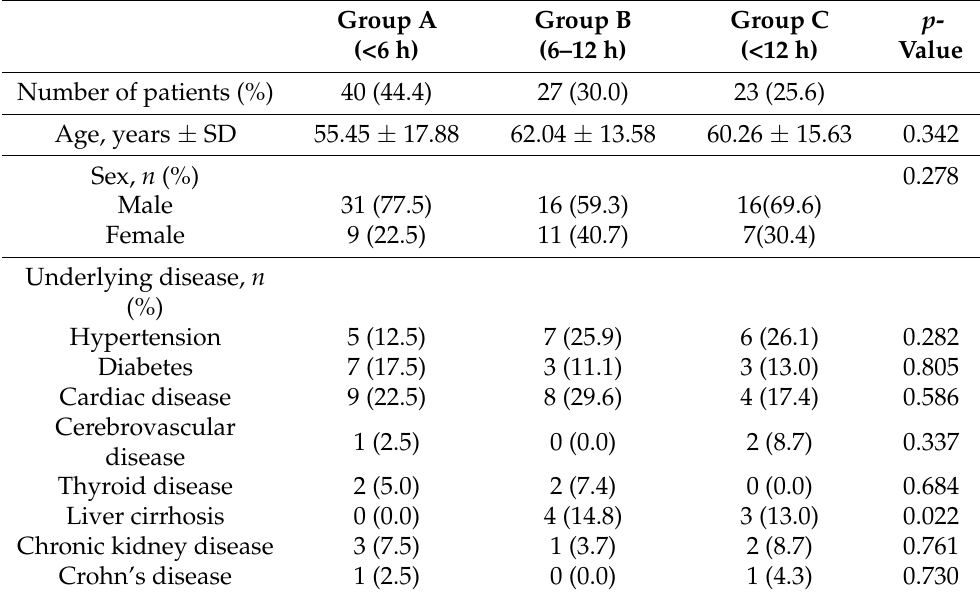
Figure 1. Flow diagram showing the selection of study subjects. Table 2. Clinical characteristics of enrolled patients according to the time interval between the last ingestion of polyethylene glycol and swallowing of small bowel capsule endoscope.